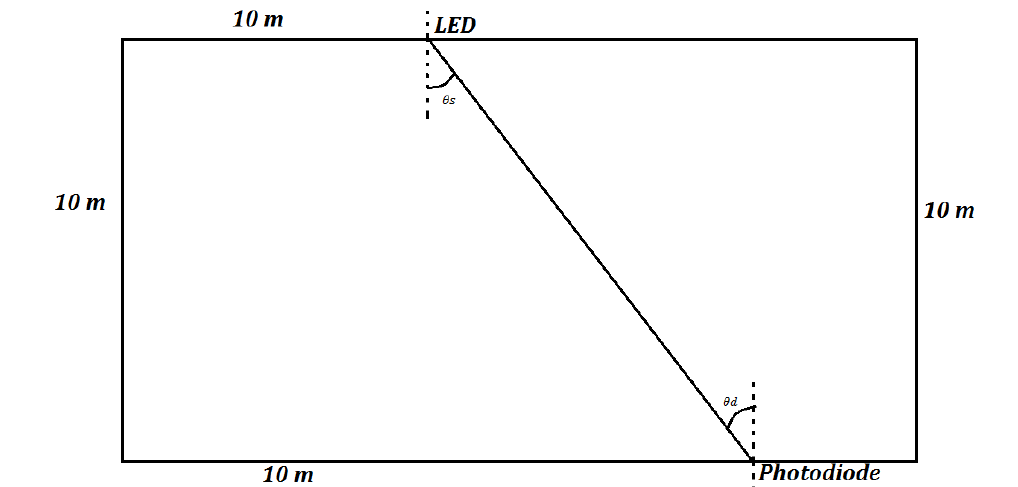
Figure 1. Experiment design for LOS propagation model. The experiment was 10 m long and considered a single LED and